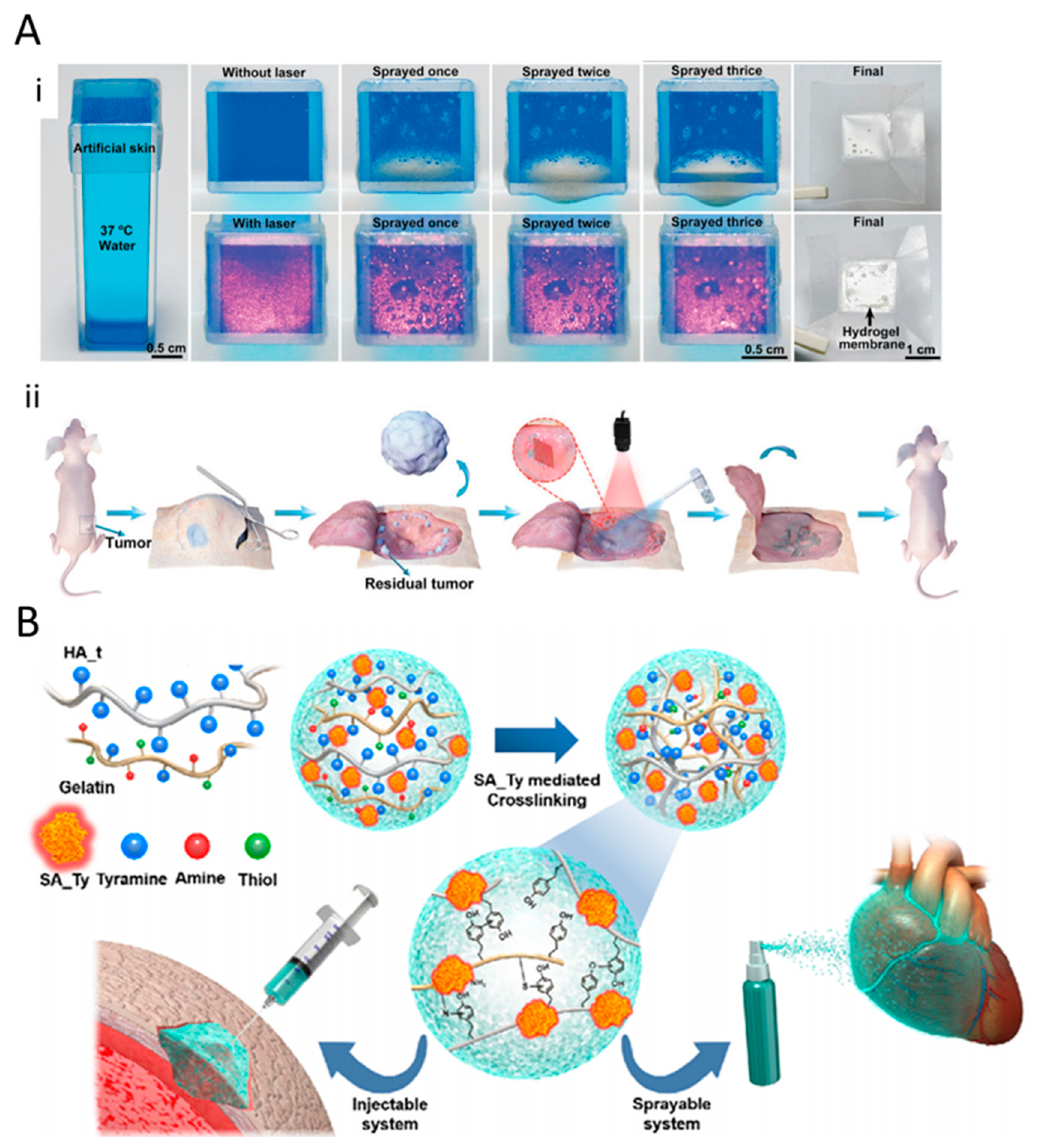
Figure 3. ( A ) (i) Camera photographs of BP@PLEL hydrogel sprayed on a piece of 37 °C artificial skin with (down) and without (up) 808 nm laser irradiation. Hydrogel membrane is formed in response to the near-infrared (NIR) laser. (ii) Schematic of the surgical treatment and postoperative photo-thermal therapy of the tumor at the site of the sprayed hydrogel. Adapted with permission from Shao et al. [71] ( B ) Illustration of the fabrication of sprayable system comprising hyaluronic acid (HA) hydrogel, crosslinked with SA-Ty mediated macromolecules (gelatin, HA_t), coupled with a neighboring amine, thiol, and another quinone. Adapted with permission from Kim et al.